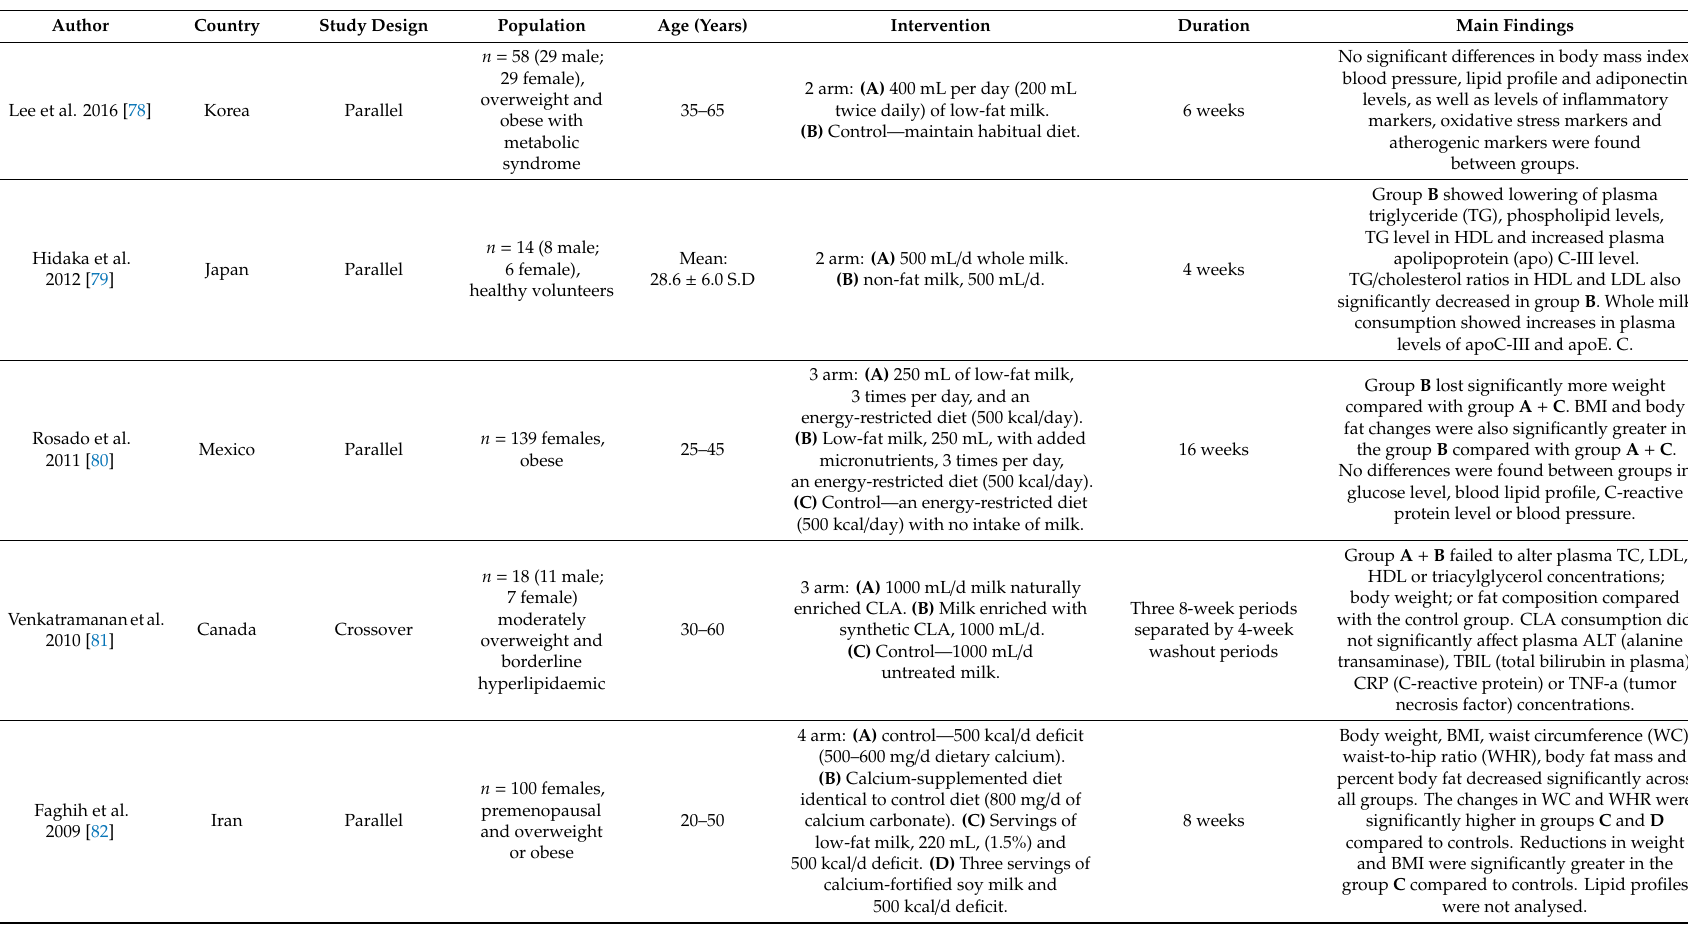
Table 3. Randomised controlled trials (RCT) demonstrating an e ff ect of milk consumption on markers of metabolic health and cardiovascular disease (CVD)